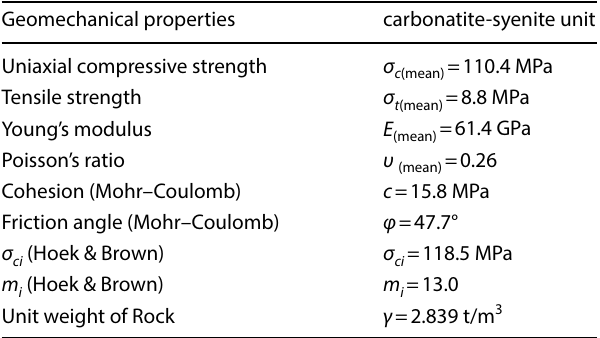
Table 9 The mean values geomechanical parameters for the car- bonatite-syenite intact rock unit Geomechanical properties